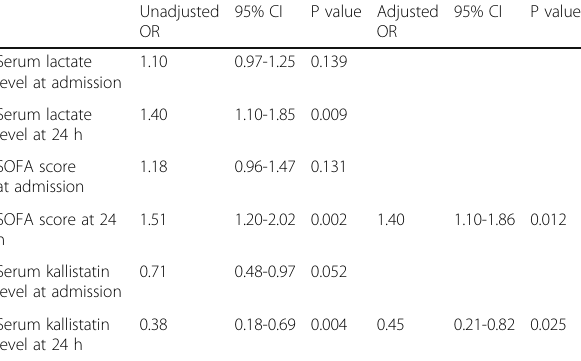
Table 2 (abstract 0119). Logistic regression analysis for 28-day